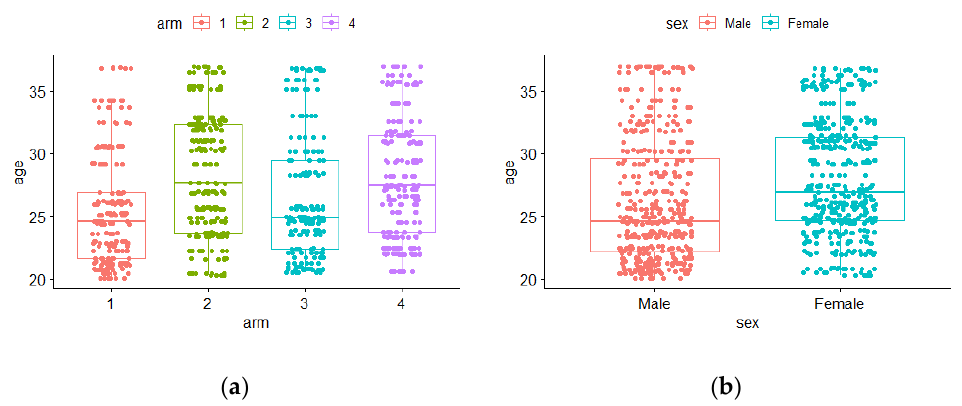
Figure 3. Boxplots for age at baseline by ( a ) arms: 1 to 4 and ( b ) sex: male or female.